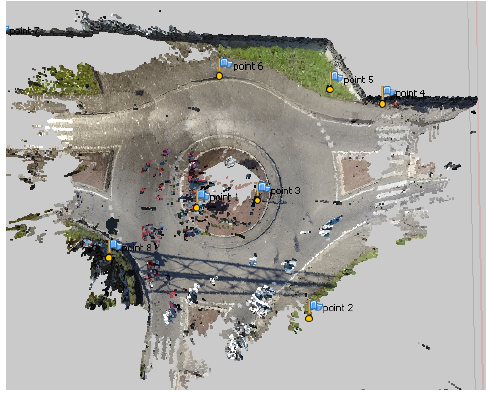
Fig. 8: Point cloud from processing of the images in the case of a traffic circle (Test #2)